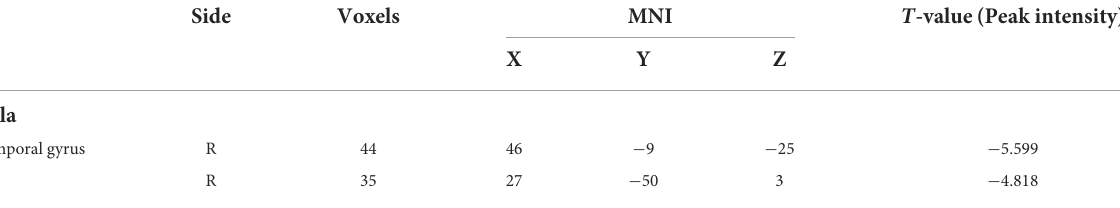
TABLE 1 Comparison of FC between pre-acupuncture in subjective tinnitus and healthy control. Regions